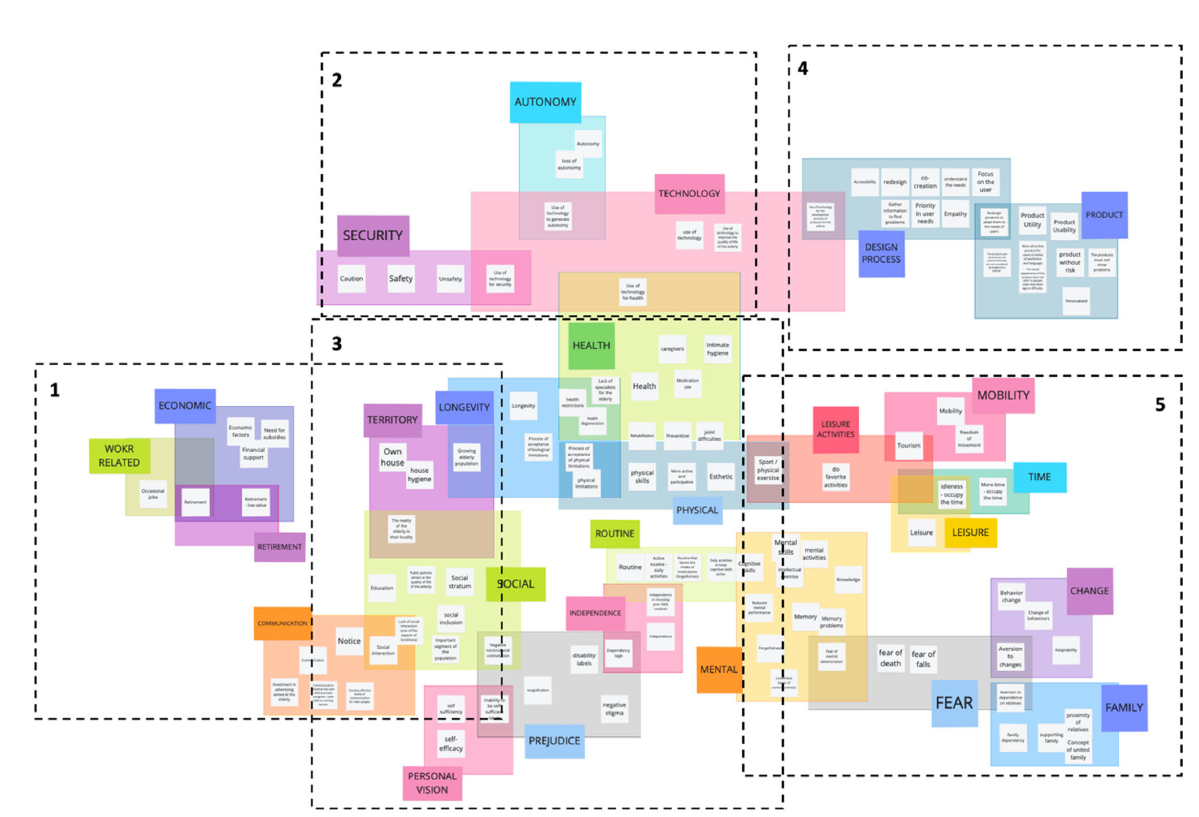
Figure 4. Mapping of activities with categories and subcategories. Source: own elaboration.